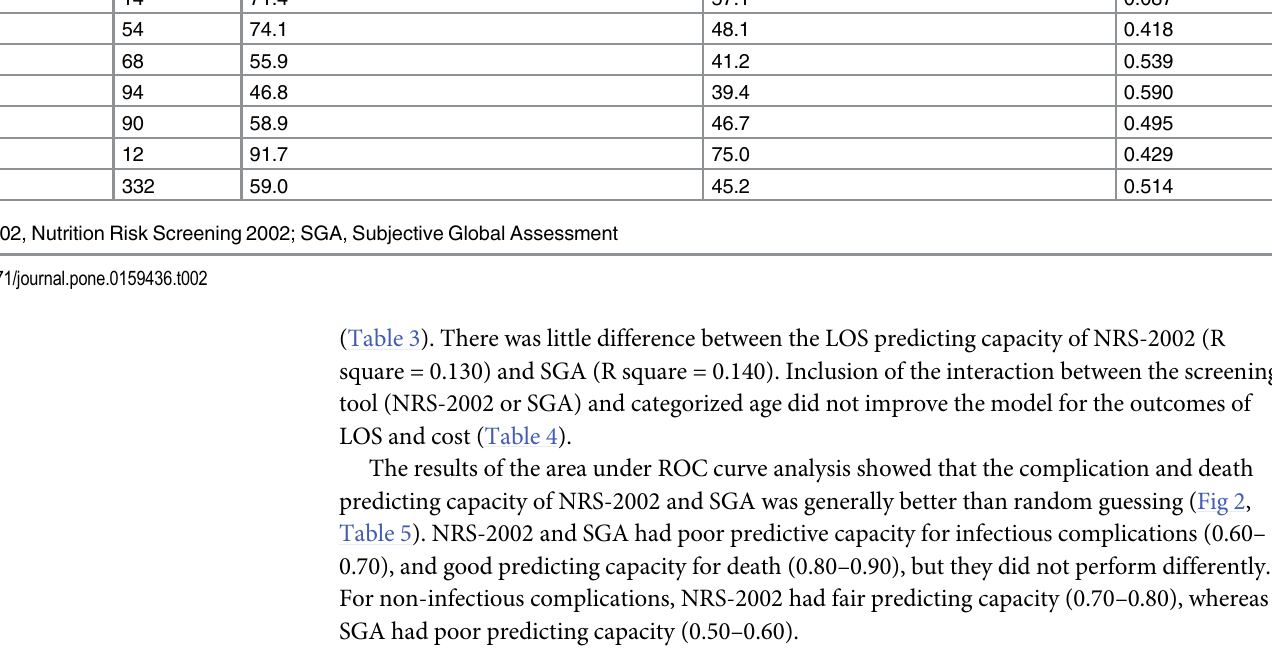
Table 2. Agreement between NRS-2002 and SGA: κ -index.